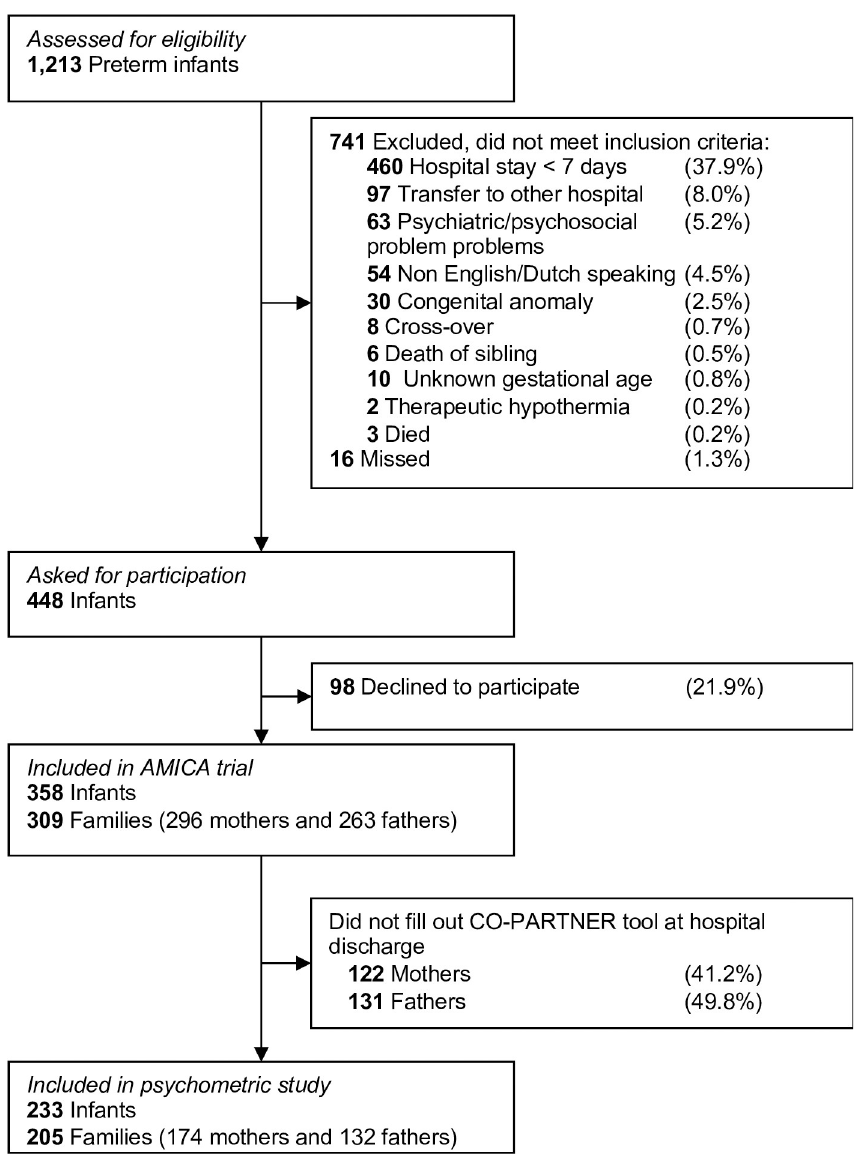
Fig 1. Flow diagram of